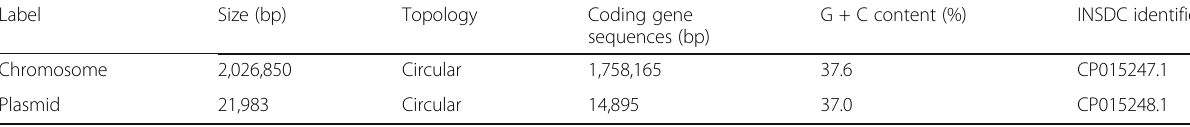
Table 3 Sequence features of chromosome and plasmid present in the L. suionicum DSM 20241 T genome Label Size